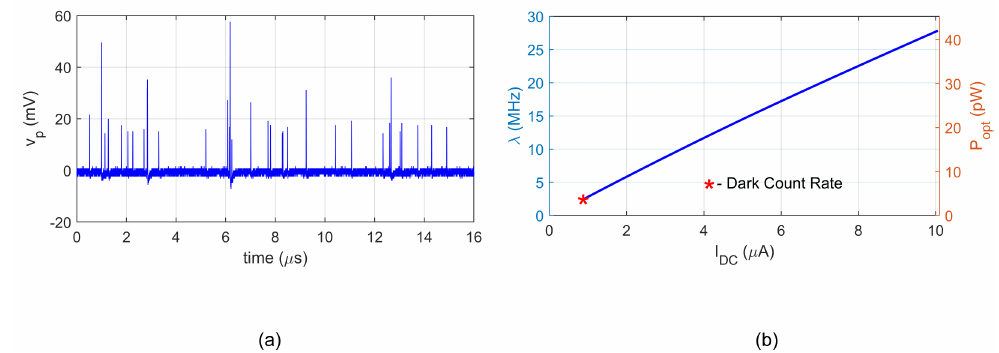
Figure 11. Measuring the event rate: ( a ) Example record with multi-event pulses. ( b ) Estimated event rate as a function of DC